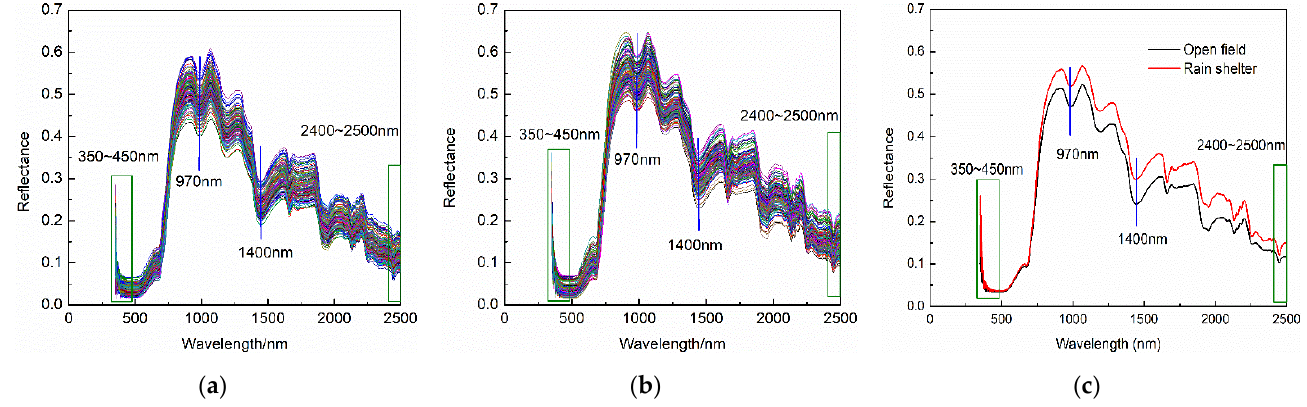
Figure 1. Mean spectrum of fresh jujubes. ( a ) Spectral curves of open-field cultivation, ( b ) spectral curves of rain-shelter cultivation, and ( c ) average spectrum.